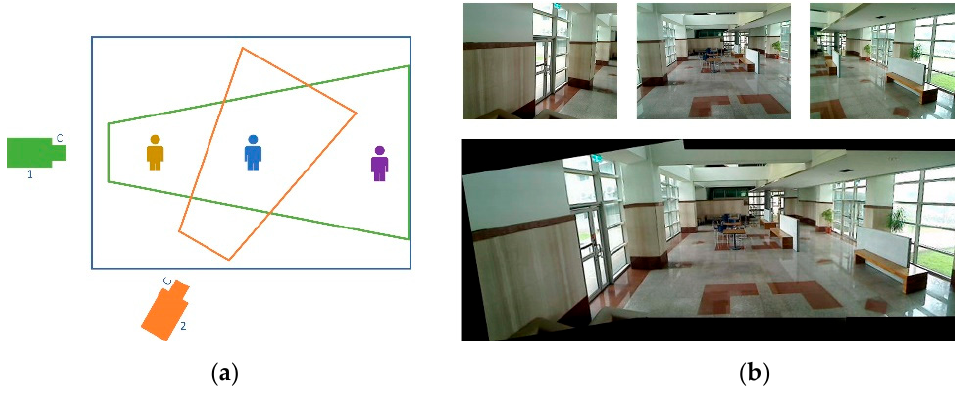
Figure 2. Multicameras scene model ( a ) FOV lines and projections ( b ) Graph Generation.